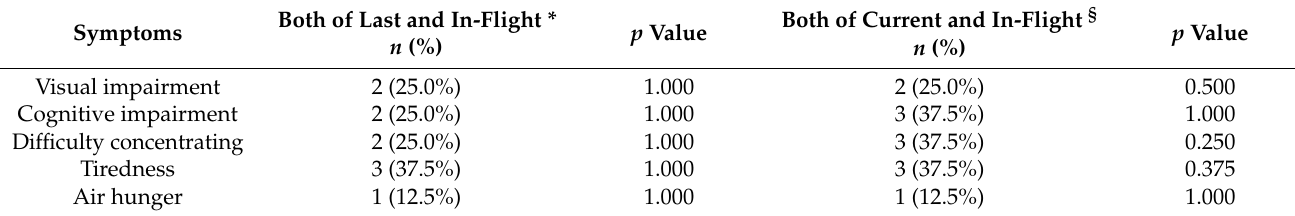
Table 5. Consistency relations of hypoxia symptoms between the last, current altitude hypoxia trainings and in-flight hypoxia